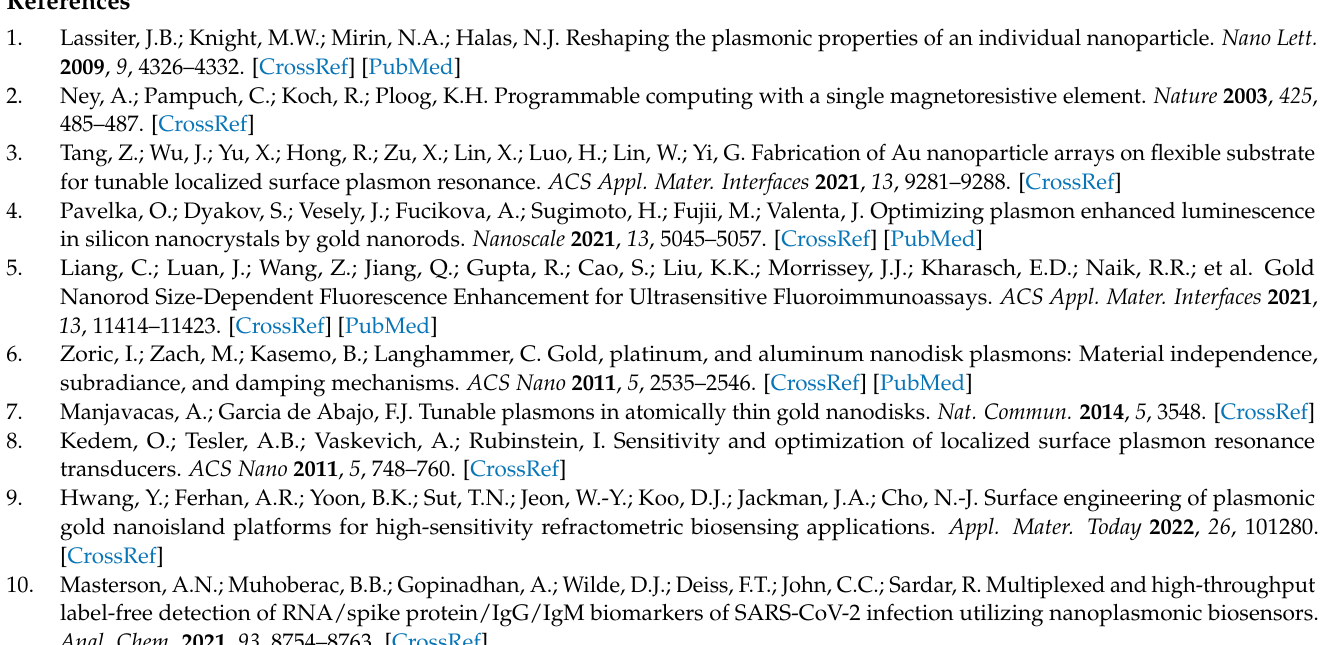
AuNRs on a glass substrate after repeated washing cycles; Figure S3: Surface morphology of AuNR platform; Figure S4: FTIR spectroscopic analysis of glass surface without and with BSA protein coating and AuNR-coated glass surface without and with BSA protein coating. References [45,77,84–94] are cited in the Supplementary